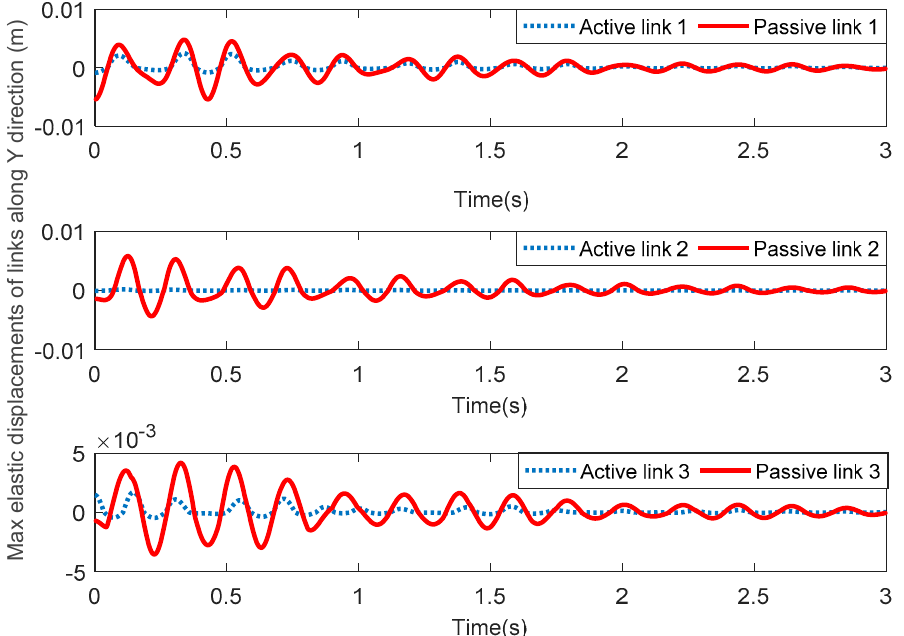
Figure 7. Maximum elastic displacements of active links and passive links along the Y direction.